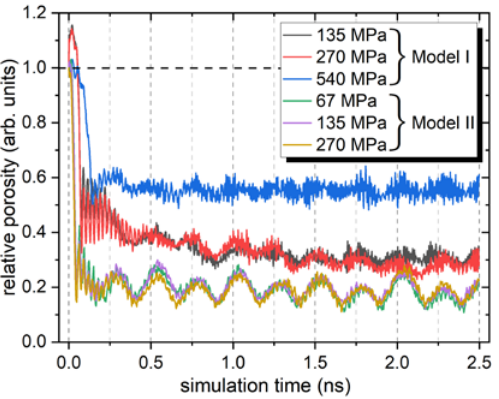
Figure 8. Relative porosity vs. simulation time during simulated USW for Model I and Model II under various applied clamping pressures. The horizontal black dashed line shows the initial relative porosity. The vertical dashed lines are located at a distance of half a period of the sinusoidal shear displacement.